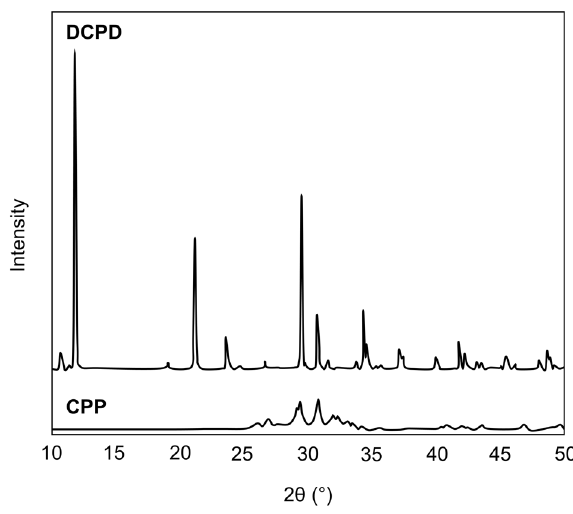
Fig. 3 XRD diffraction patterns of DCPD and CPP seed